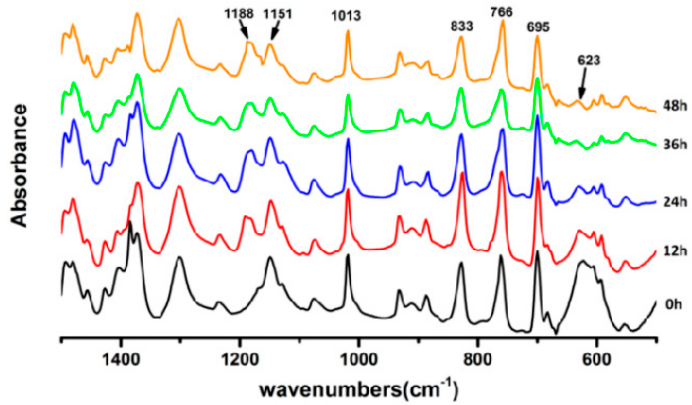
Figure 5. The infrared absorbance of FTPB-PDMI’s functional group with the reaction time (the stretching vibration of furan rings corresponding to the peaks at 1151 and 1013 cm − 1 ; the peaks at 1188 cm − 1 corresponding to the C–C bonds’ stretching vibration of Diels–Alder adducts; the peaks at 833, 766, and 695 cm − 1 corresponding to out-of-plane bending vibration of C–H bonds on C–C bonds; the peaks at 623 cm − 1 corresponding to the out-of-plane bending vibration C–H bonds on C=C bonds of maleimide).